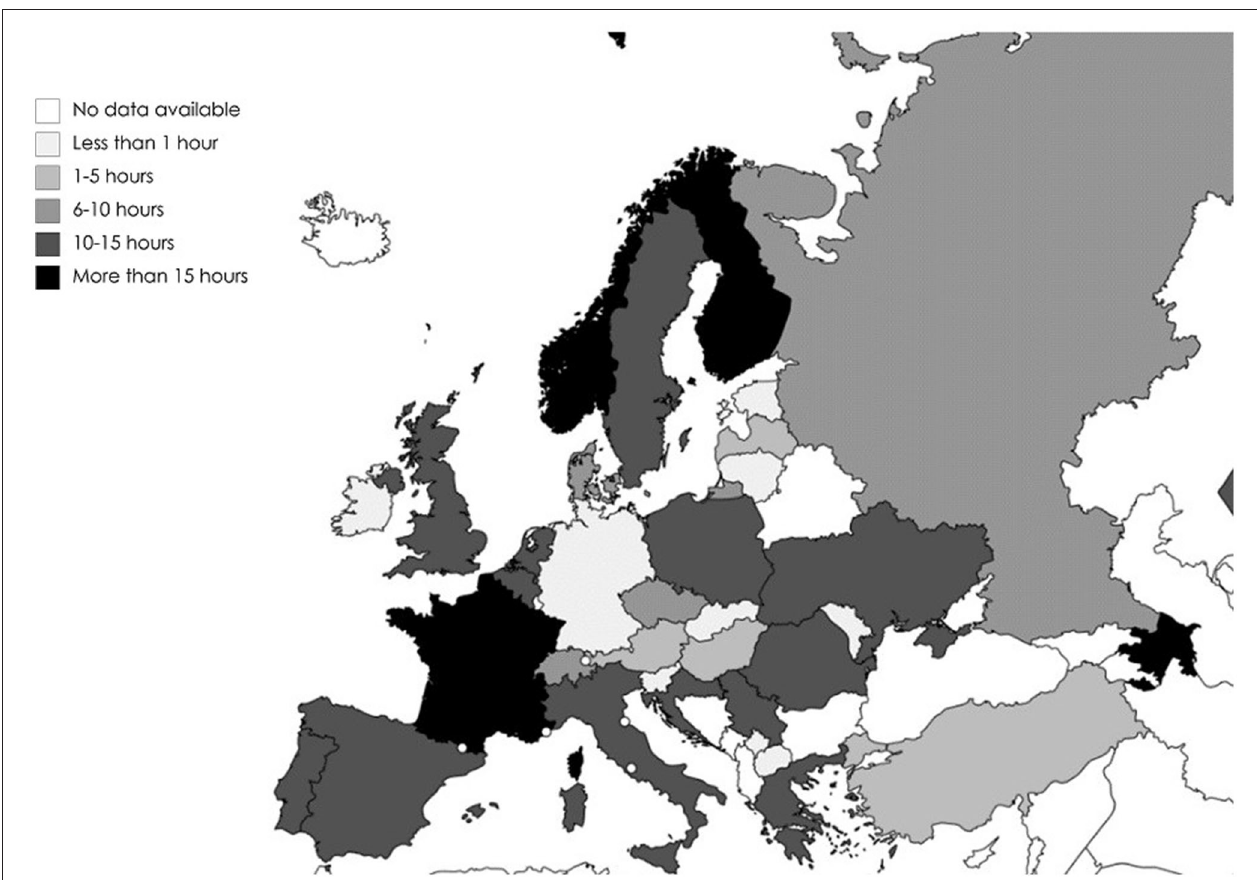
FIGURE 2 | Hours (per week) spent in research per country of